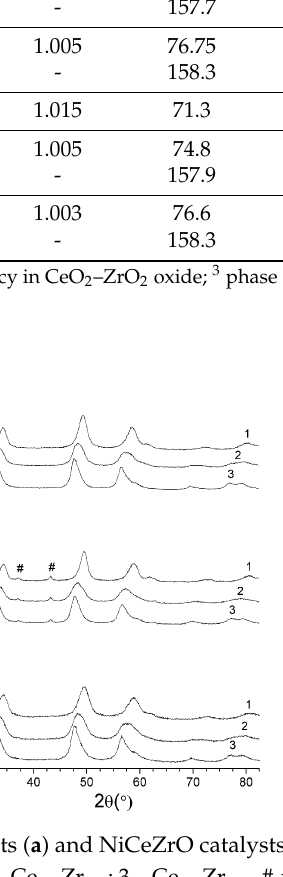
Table 2. Lattice parameters and phase composition of Ce x Zr 1-x O 2 and Ni-Ce x Zr 1-x O 2 op samples.